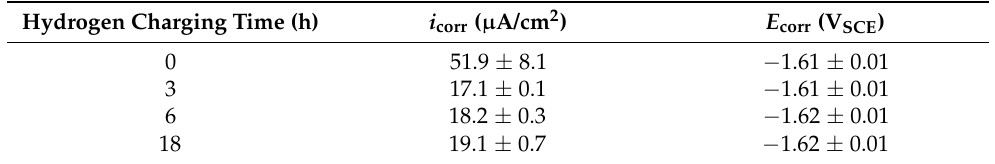
Figure 6. Potentiodynamic polarization curves of differently charged samples measured in a 0.1 M NaCl solution. Table 2. Fitting results from the polarization curves of differently charged samples measured in a 0.1 M NaCl solution.